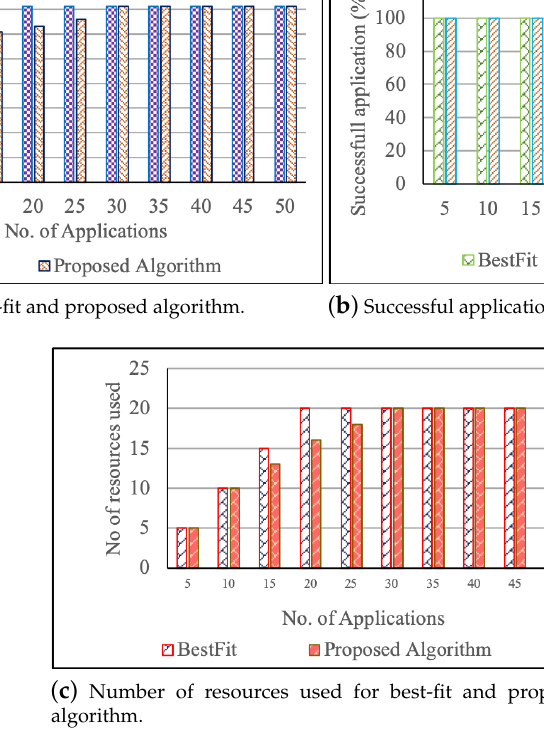
Figure 3. Comparison of cost, resources used, and successful application between the Proposed and BestFit algorithm when the fog devices are